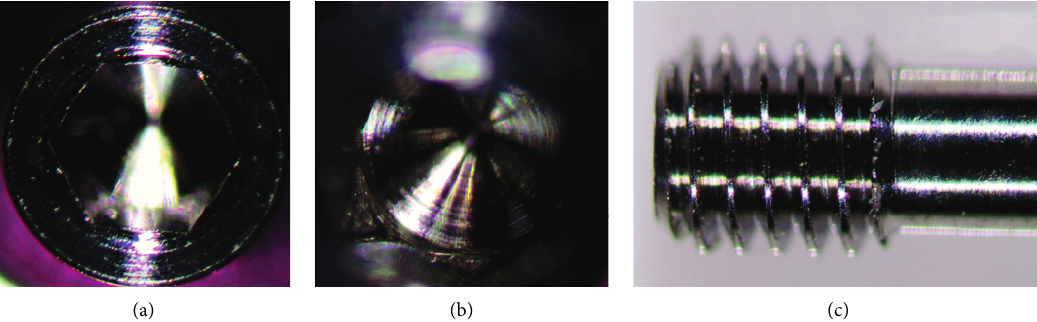
Figure 10: Exaktus ® screw magnification analysis: (a) screw head, (b) inside screw connection, and (c) screw thread